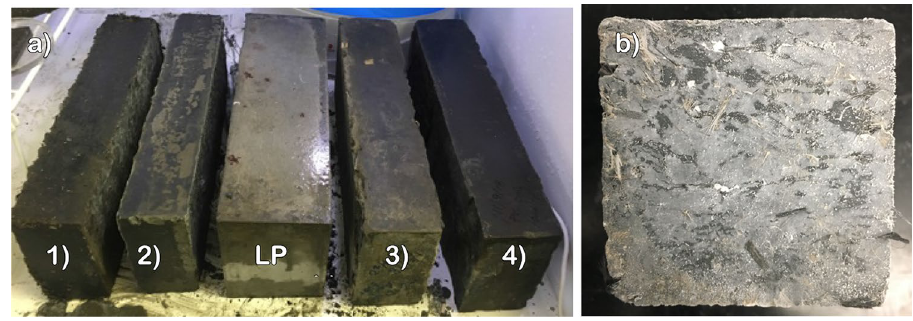
Table 3 Manufacturer specifications for simulated sea